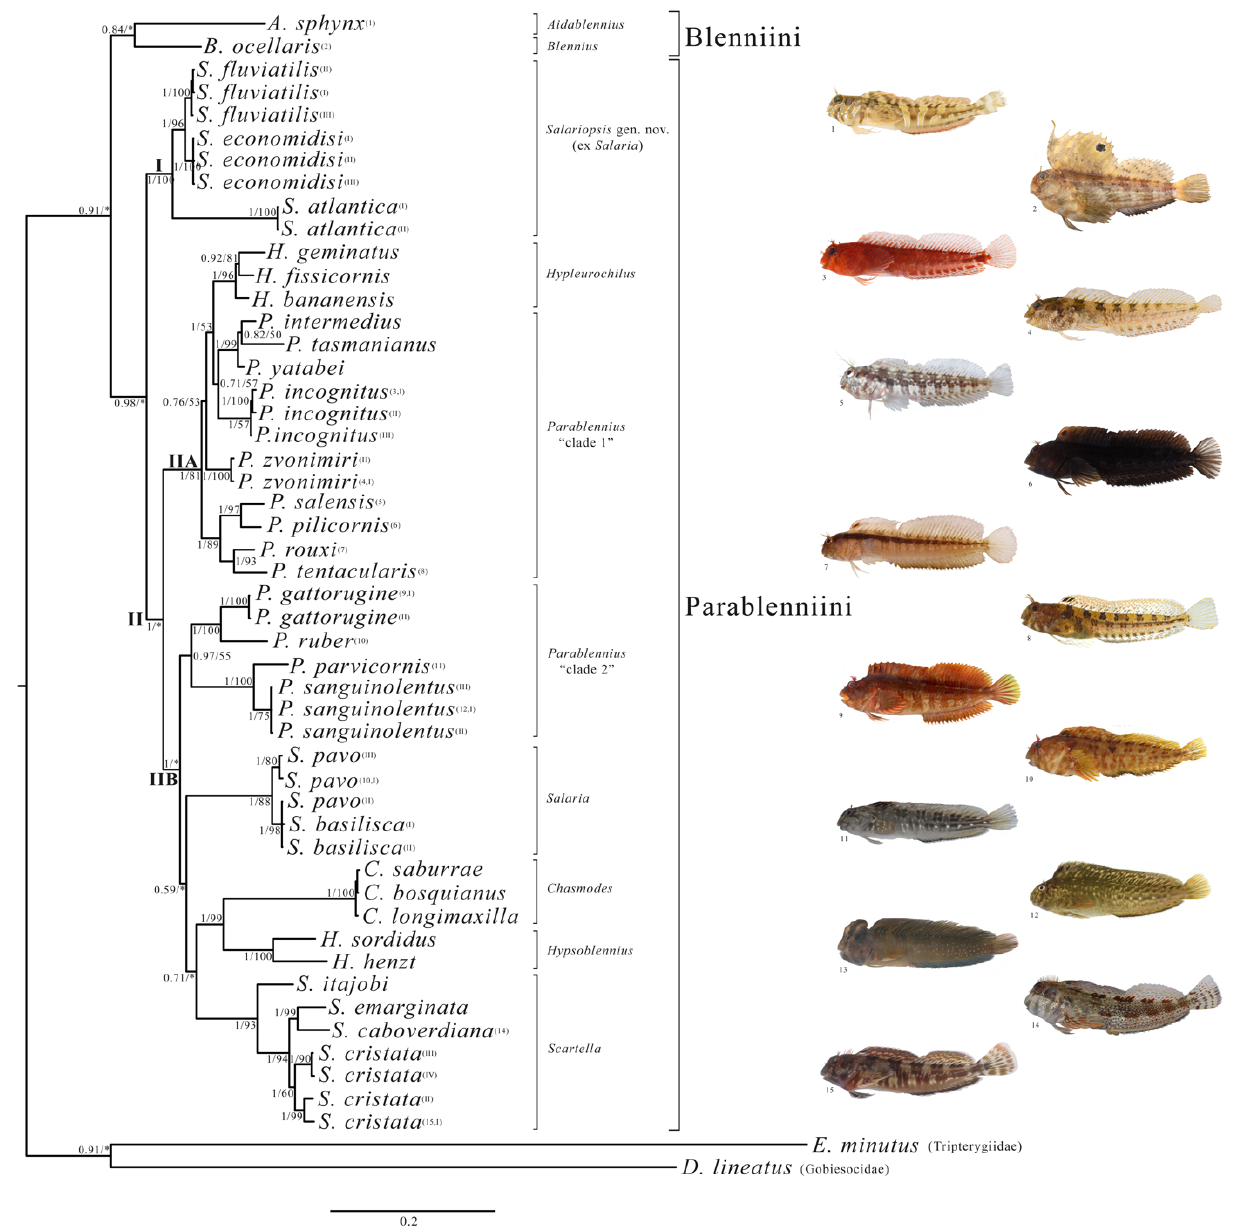
Figure 1. Bayesian phylogram of the studied Blenniidae samples based on the concatenated mtDNA and nuDNA dataset. Node statistical support is reported as nodal posterior probabilities (Bayesian Inference of phylogeny, BI)/bootstrap values (maximum likelihood, ML). Asterisks indicate a bootstrap support value lower than 50. Square brackets group the samples according to the current taxonomy. Arabic numbers in brackets refer to the blennies’ images attached next to the phylogram. Roman numbers in brackets refer to specimens listed in Table 1. (I), freshwater Salariopsis gen. nov. (ex Salaria ) clade; (II), marine Parablenniini clade; (IIA), Hypleurochilus and Parablennius “clade 1” subclades; (IIB), Parablennius “clade 2”, Salaria , Chasmodes , Hypsoblennius and Scartella subclades.